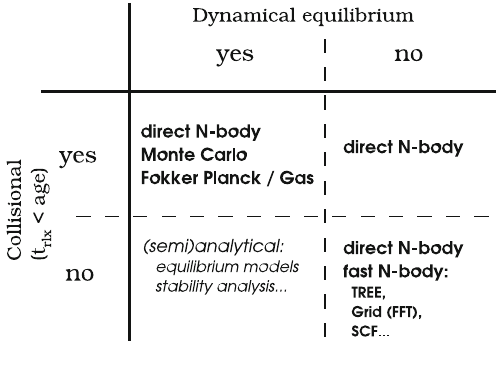
Fig. 62 Possible methods to study the various realms of stellar